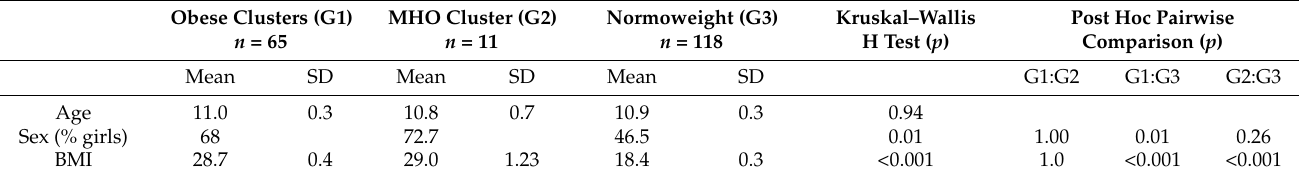
Table 1. General characteristics of the studied